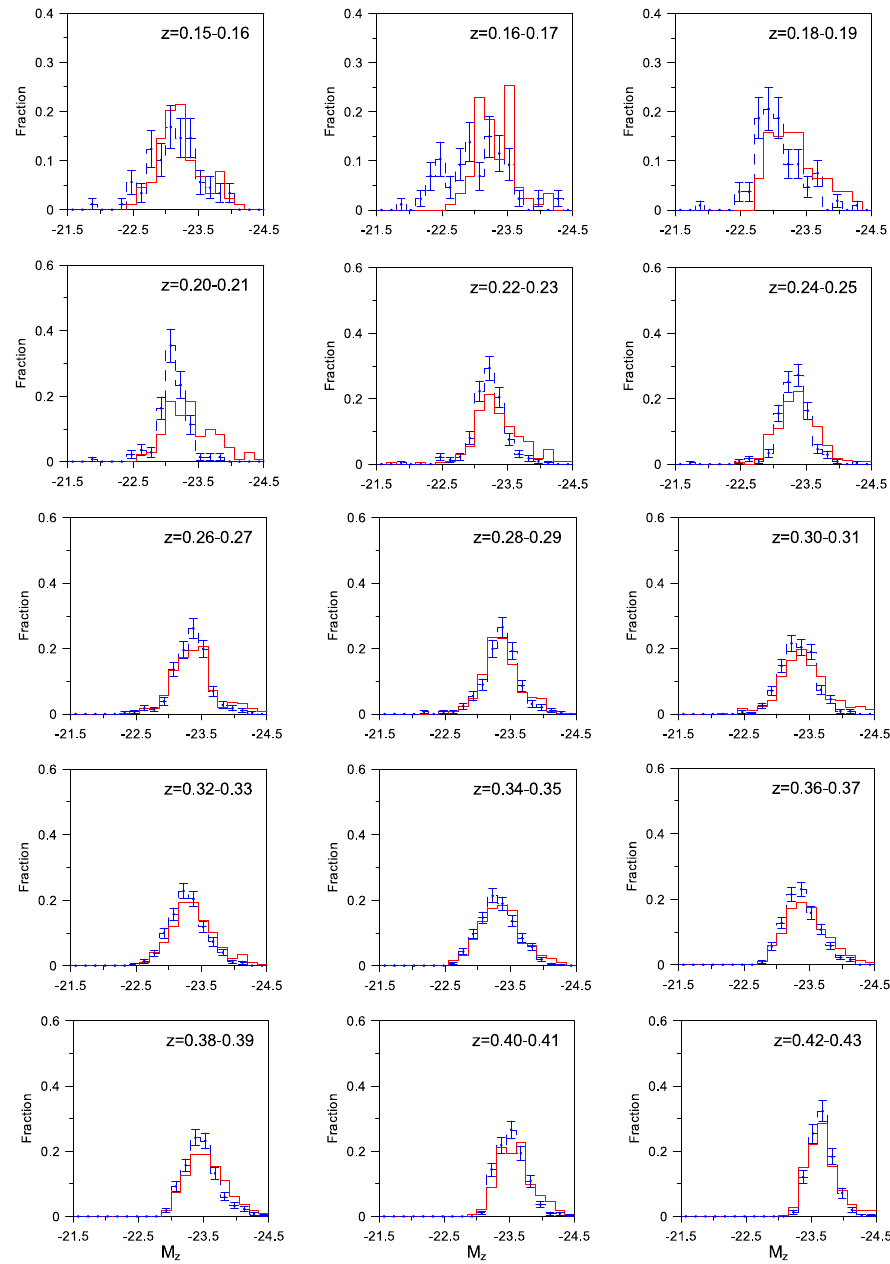
Fig. 5. Same as Fig. 1, but for the z -band absolute magnitude distribution at both density extremes in different redshift